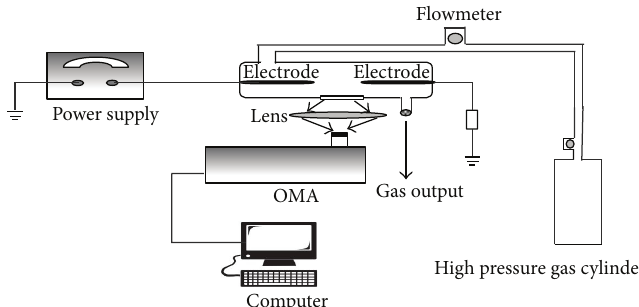
Figure 1: Schematic diagram of the pulse-discharged system for NO